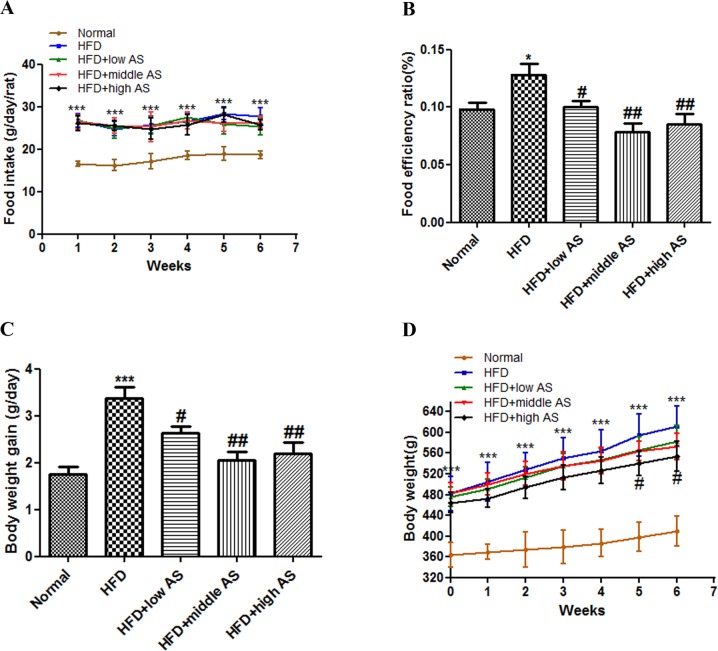
AS extract reduces HFD-induced obesity in rats.Rats were randomly divided into five groups: normal control, HFD model, and HFD with AS extract (100, 300, or 900 mg/kg). The extract was intragastric administered for 6 weeks. (A) Food intake per rat was recorded six times a week. (B) Food efficiency ratio was calculated as body weight gain divided by food intake. (C) Change in body weight was measured six times a week. (D) Body weight gain measured in a given week was subtracted from the weight in the previous week. Values are expressed as mean ± SE (n = 30). Significant differences were observed between normal and HFD groups. *P < 0.05, **P < 0.01, ***P < 0.001 vs. normal group; #P < 0.05, ##P < 0.01, ###P < 0.001 vs. model group.